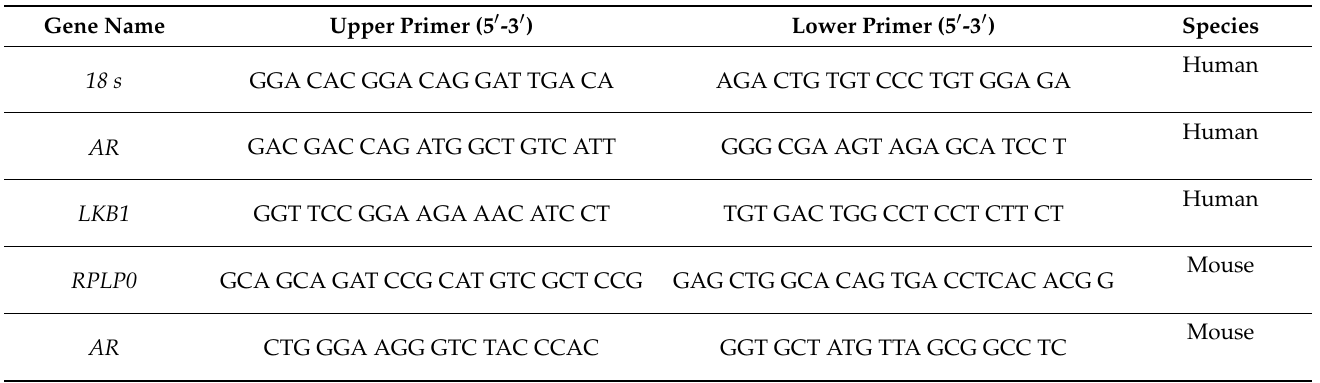
Table 2. Primers used for Real-Time Quantitative